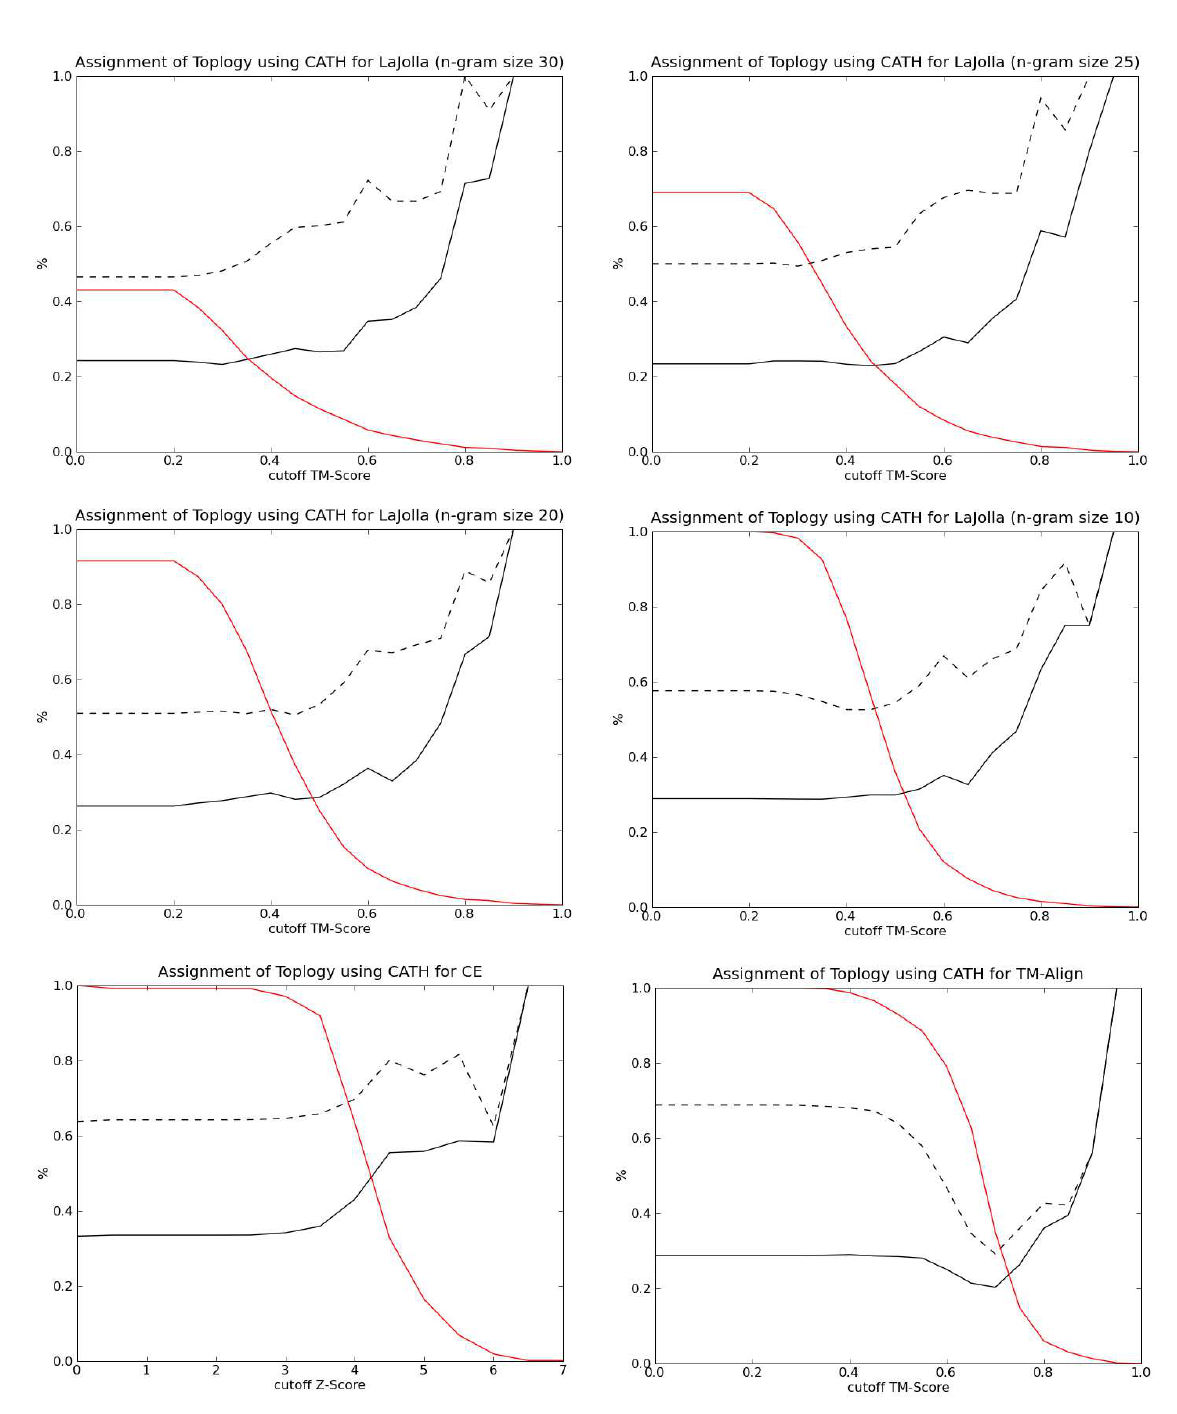
Figure 5. Evaluation of the coverage and precision of LaJolla (n-gram size 10, 20, 25, 30), CE and TM-align in a classification scenario. The red line indicates the percentage of the coverage of distinct topologies at a certain score cutoff. The black line represents the percentage of correct hits with the best score (TOP 1), the dashed black line represents the percentage of correct assignments with a true result being among the ten best hits (TOP